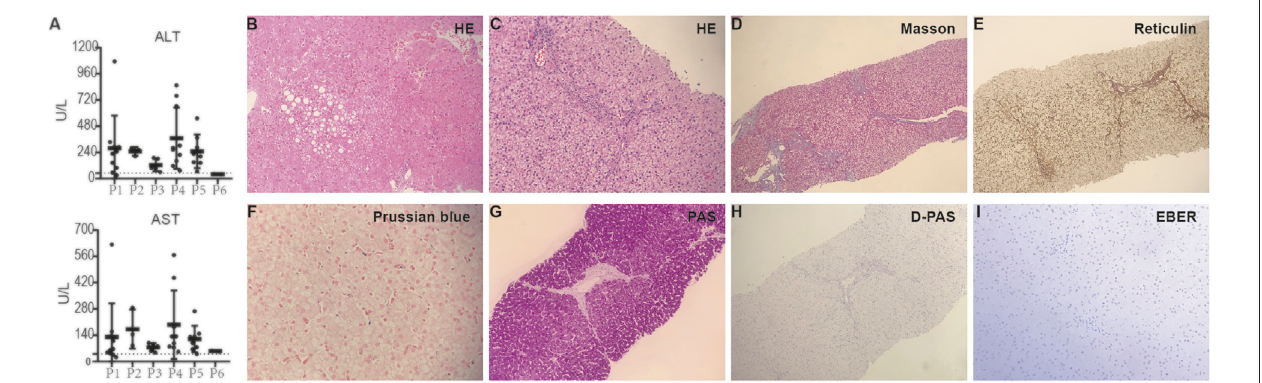
FIGURE1| Abnormal liverfunctiontests andpathological fi ndingsoflivertissuesinpatients withXMENdiseaseinthisstudy. (A) ALT(upperpanel) and AST(lower panel) levels in all patients with a normal range (the dotted line, except for P6) and patients ’ identities (shown on the X -axis). (B – H) Representative images depicting histopathologic fi ndings from liver biopsy tissues of patients. (B & C) Hematoxylin and eosin staining results showing mild hepatocyte swelling, hepatosteatosis, periportal fi brosis, in fl ammatory in fi ltrations and sinusoidal iron deposits, ×200. (D) Masson ’ s Trichrome staining results showing periportal fi brosis and bridging fi brosis, ×100. (E) Reticulin staining results showing preserved despite focal disrupted reticulin framework, ×100. (F) Prussian blue staining results showing mild iron deposition in hepatocytes, ×100. PAS (G) and D-PAS (H) staining depicting diffuse glycogenosis, ×100. (I) Liver tissues from patient 1 were negative for EBER staining, ×200. P ,